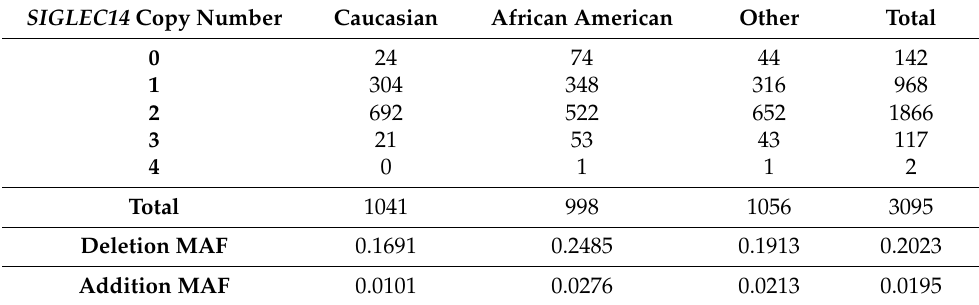
Table 4. Summary of the SIGLEC14 CNV in the 3095 sample ADSP WGS dataset.